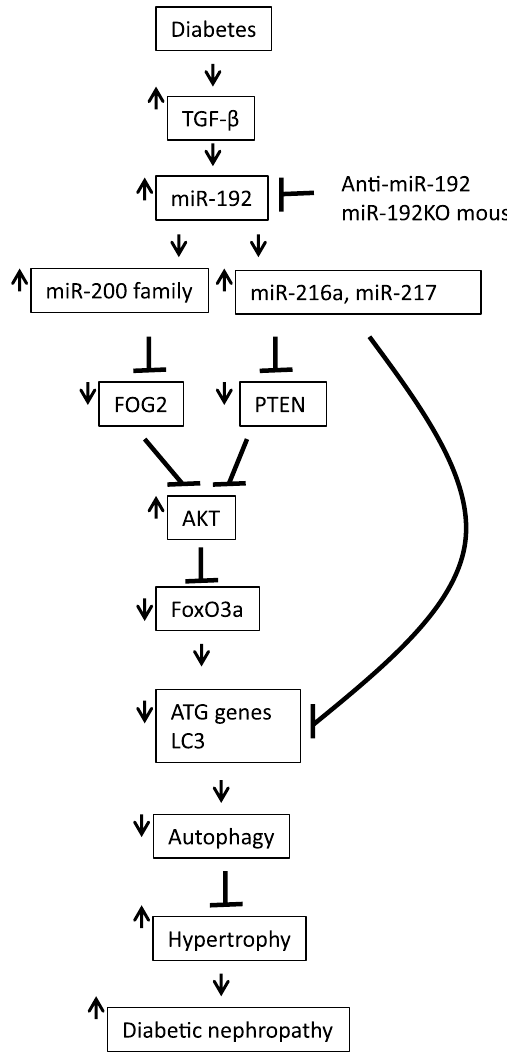
Figure 7. Proposed model showing the regulation of autophagy by miR-192-mediated cascade under diabetic conditions leading to the pathogenesis of DN. Please read main text for